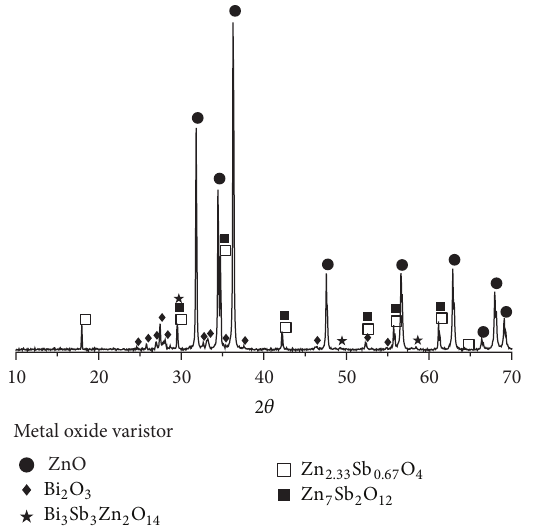
Figure 2: XRD spectra of the MOV showing peaks for ZnO ( e ), Bi 2 O 3 ( X ), Zn 2.33 Sb 0.67 O 4 ( ◻ ), Zn 2 Bi 3 Sb 3 O 14 ( ‰ ), and Zn 7 Sb 2 O 12 ( ◼